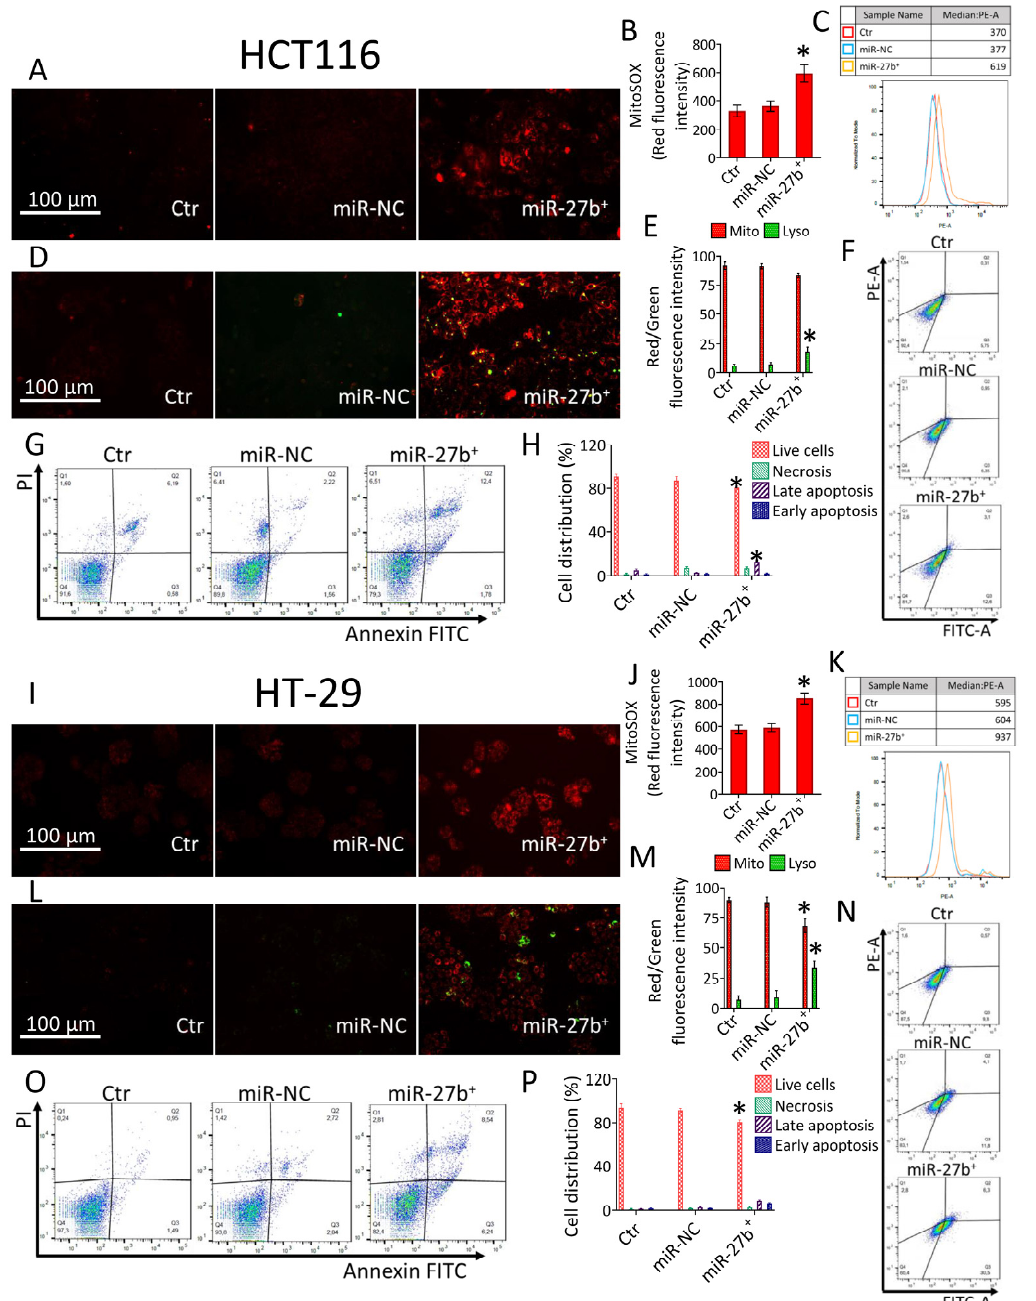
Figure 2. MiR-27b induced mitochondrial stress and apoptosis. ( A – C , I – K ) Representative images by fluorescence microscopy and FACS analysis of mitochondrial ROS detection, ( D – F , L – N ) mitophagy (red) and lysosome (green) dyes, and ( G – H , O – P ) representative dot plots and analyses of annexin V-FITC and propidium iodide (PI)-staining in HCT116 and HT-29 cells transfected for 72 h with 30 nM mimic Negative Control (miR-NC) and miR-27b mimic (miR-27b + ). Control cells (Ctr) were treated with the highest volume of HBSS-10 mM Hepes. Scale bars = 100 µm. Cell viability/death was assessed by flow cytometry detecting at least 20,000 events. Lower left quadrant: viable cells; upper left quadrant: necrotic cells; lower right quadrant: early apoptotic cells; upper right quadrant: late apoptotic cells. * p < 0.05 vs. miR-NC.